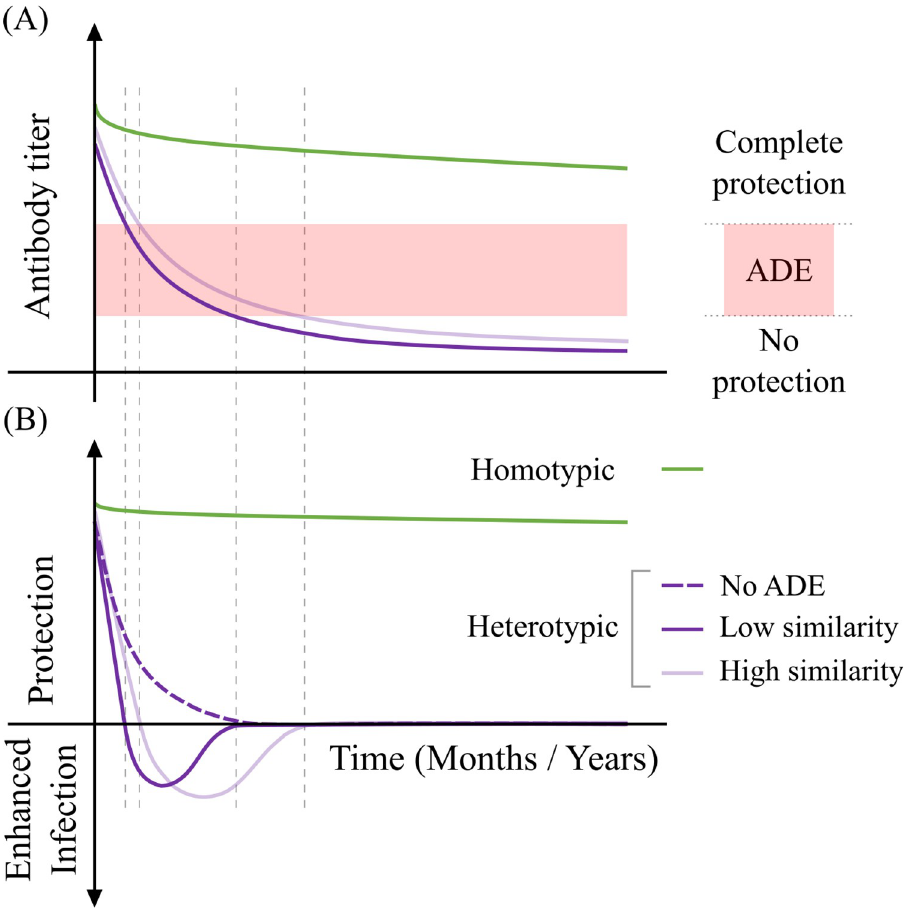
Fig 6. Schematic for antibody-mediated protection from secondary dengue infection. (A) Antibody decay dynamics and (B) corresponding level of protection during the secondary infection. Homotypic antibodies and protection from homotypic infection wane slowly (green). Cross-reactive antibodies to heterotypic dengue and protection wane faster (purple). Sequence similarity between the primary and secondary infecting serotypes is shown by shades of purple. The red shaded area represents the window of the antibody titer in which ADE is in effect. The dotted purple line represents protection response in the absence of ADE.